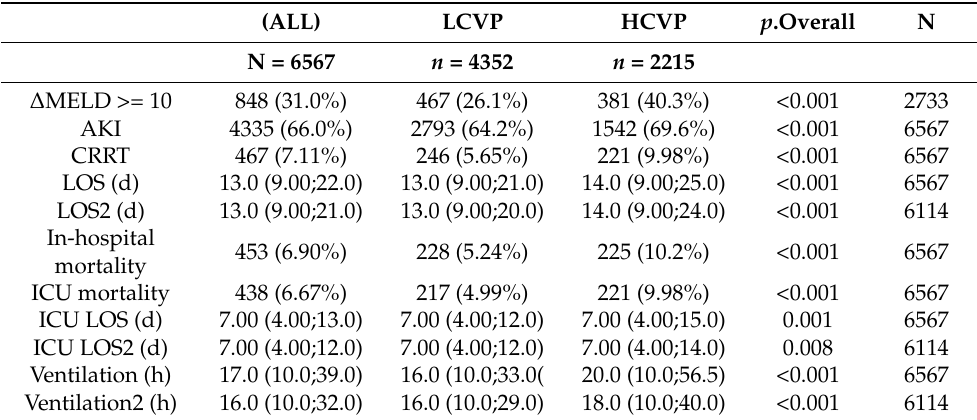
Table 2. Outcome parameters of matched